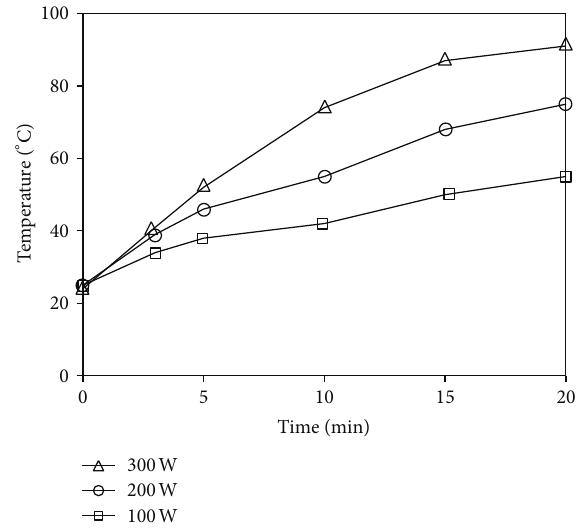
F 1: Effects of MW power on MB-containing solution temper- ature changes with